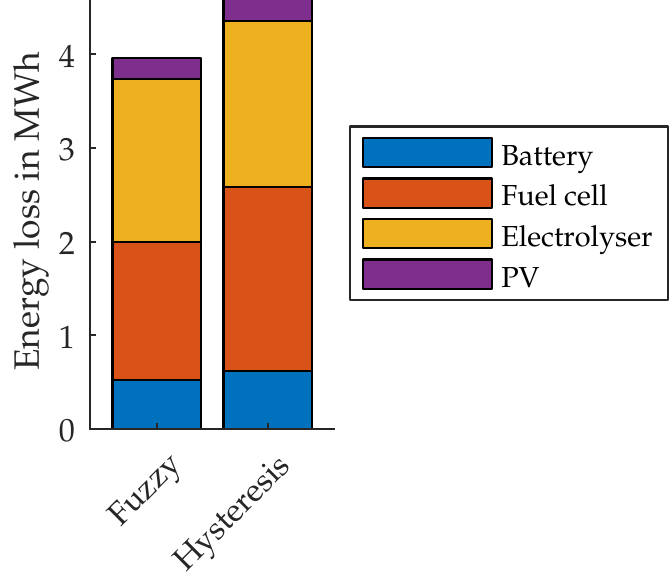
Figure 13. Distribution of